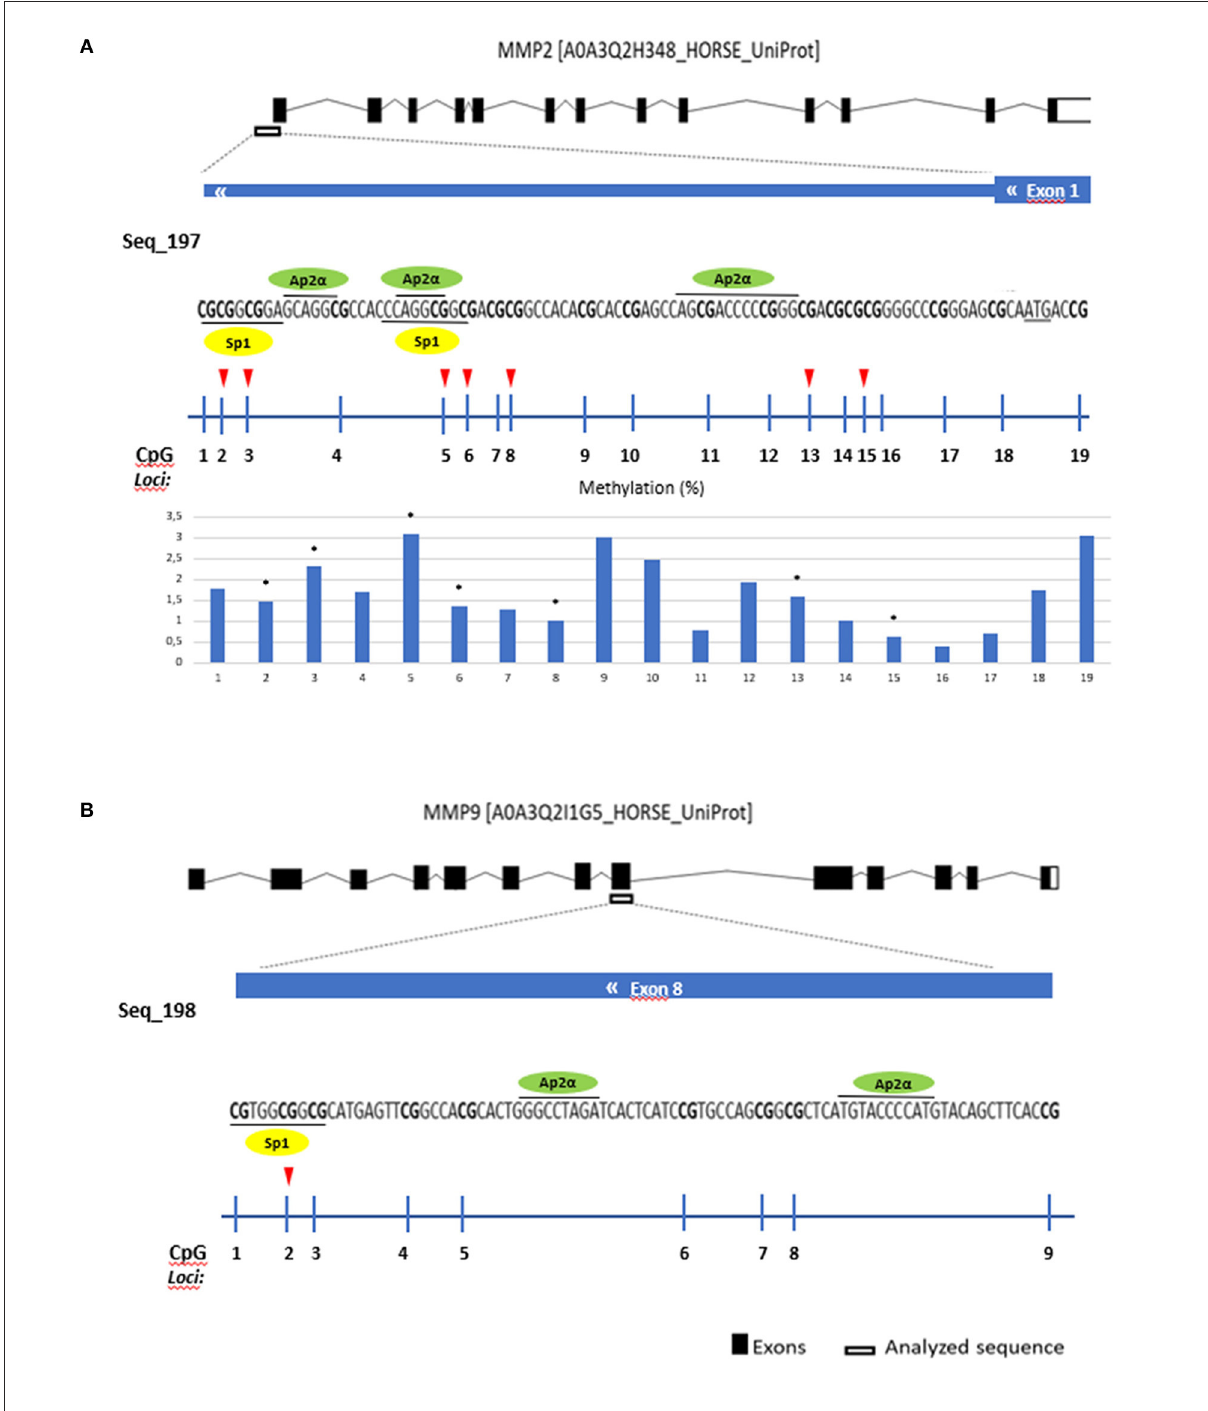
FIGURE6 Gene analyzed sequence, binding transcription factors and methylation (%) in equine endometrial categories graded as Kenney and Doig’s classification per CpG position in (A) MMP2 and (B) MMP9. Sp1 - proximal specificity protein 1, AP2 α - Activator protein 2. Red arrows and asterisks indicate significant differences between CpG positions (* P <